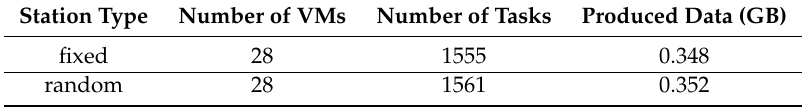
Table 2. Used Virtual Machines (VMs), number of tasks and produced data in scenario N o